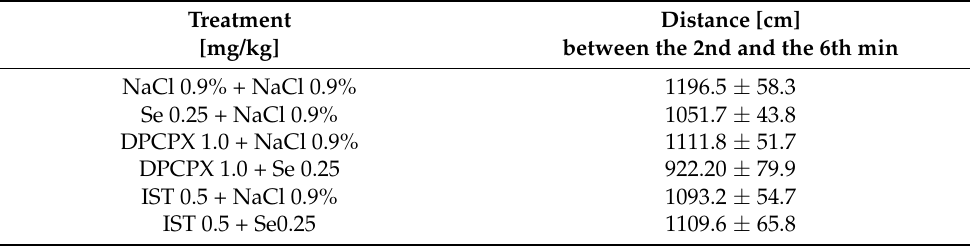
Table 2. Effect of co-treatment on mice spontaneous locomotor